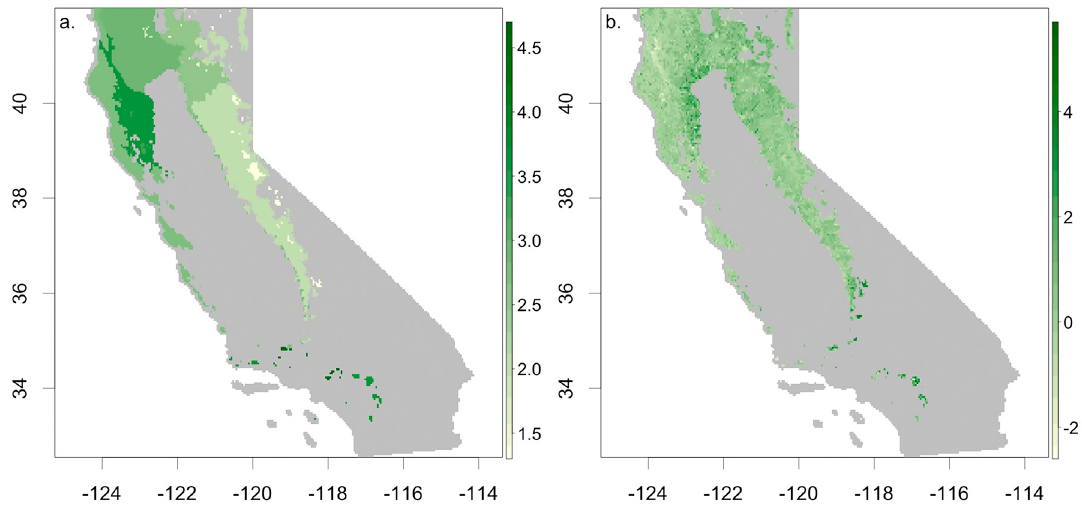
Figure 4. Variation in ( a ) WUE BASELINE and ( b ) Δ WUE across California forests. Similar to patterns observed across California ecosystems [8], WUE BASELINE was highest in arid regions and Δ WUE in 2014 indicated that some areas exhibited resilience while others showed a decline in WUE from the baseline under extreme drought conditions. The latitude and longitude are shown along the axes.